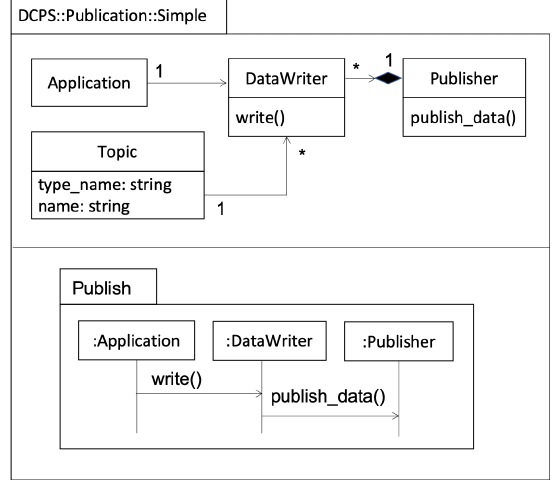
Figure 3. Simple publication